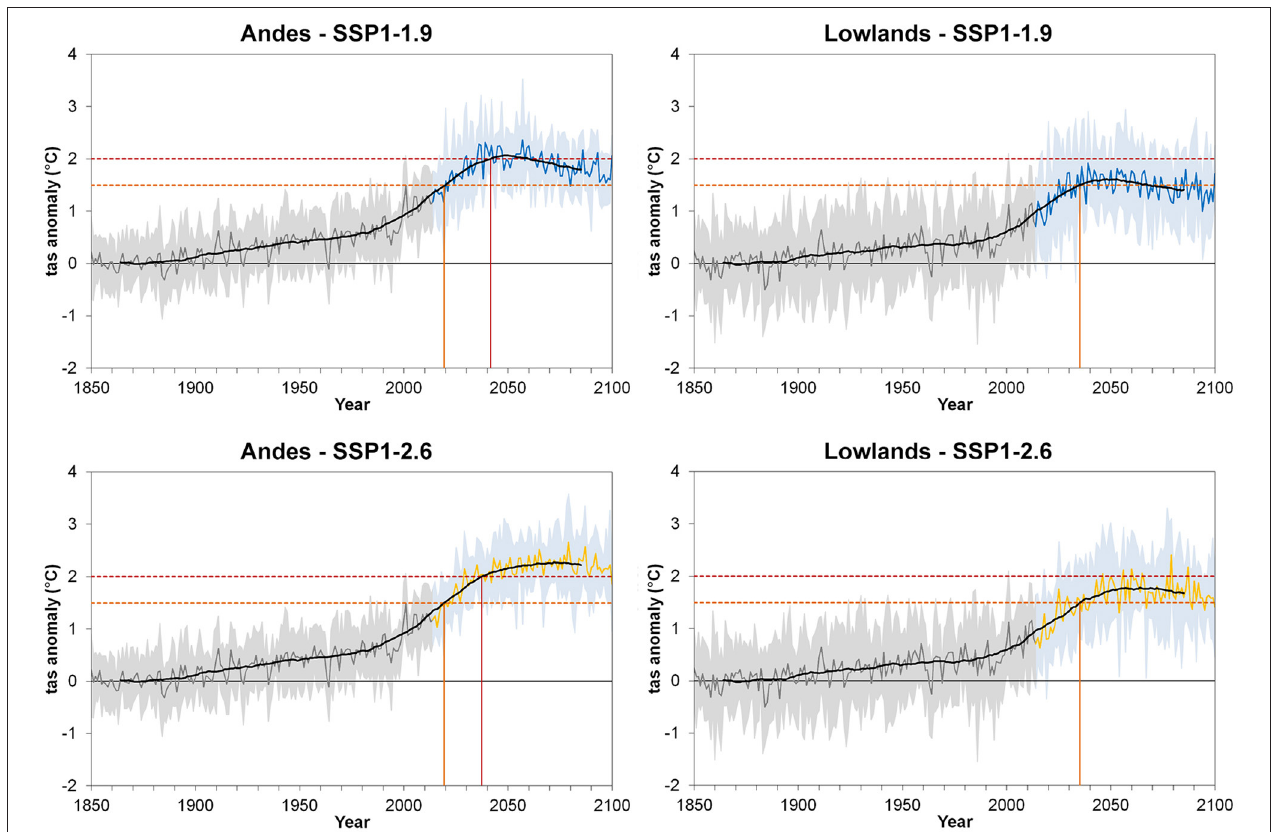
FIGURE 3 | Near-surface air temperature (tas) anomaly time series relative to the 1861-1890 pre-industrial baseline for the Andes (left panels) and Lowlands (right panels) regions and for the SSP1-1.9 (upper panels) and SSP1-2.6 (lower panels) scenarios from the IPSL-CM6A-LR runs. The dark gray lines show the series from the historical model ensemble; while the blue and orange lines continue the series using the model ensemble from the future projections under the SSP1-1.9 and SSP1-2.6 scenarios, respectively. The gray and light blue shading indicates the 5 and 95% quantiles derived from the dispersion of the historical runs (1850–2014) and future runs (2015–2100), respectively. The thick black line shows the 30-year moving average. The horizontal dashed lines indicate the 1.5 and 2 ◦ C thresholds, while the vertical lines show the year when the simulations reach the defined increases in